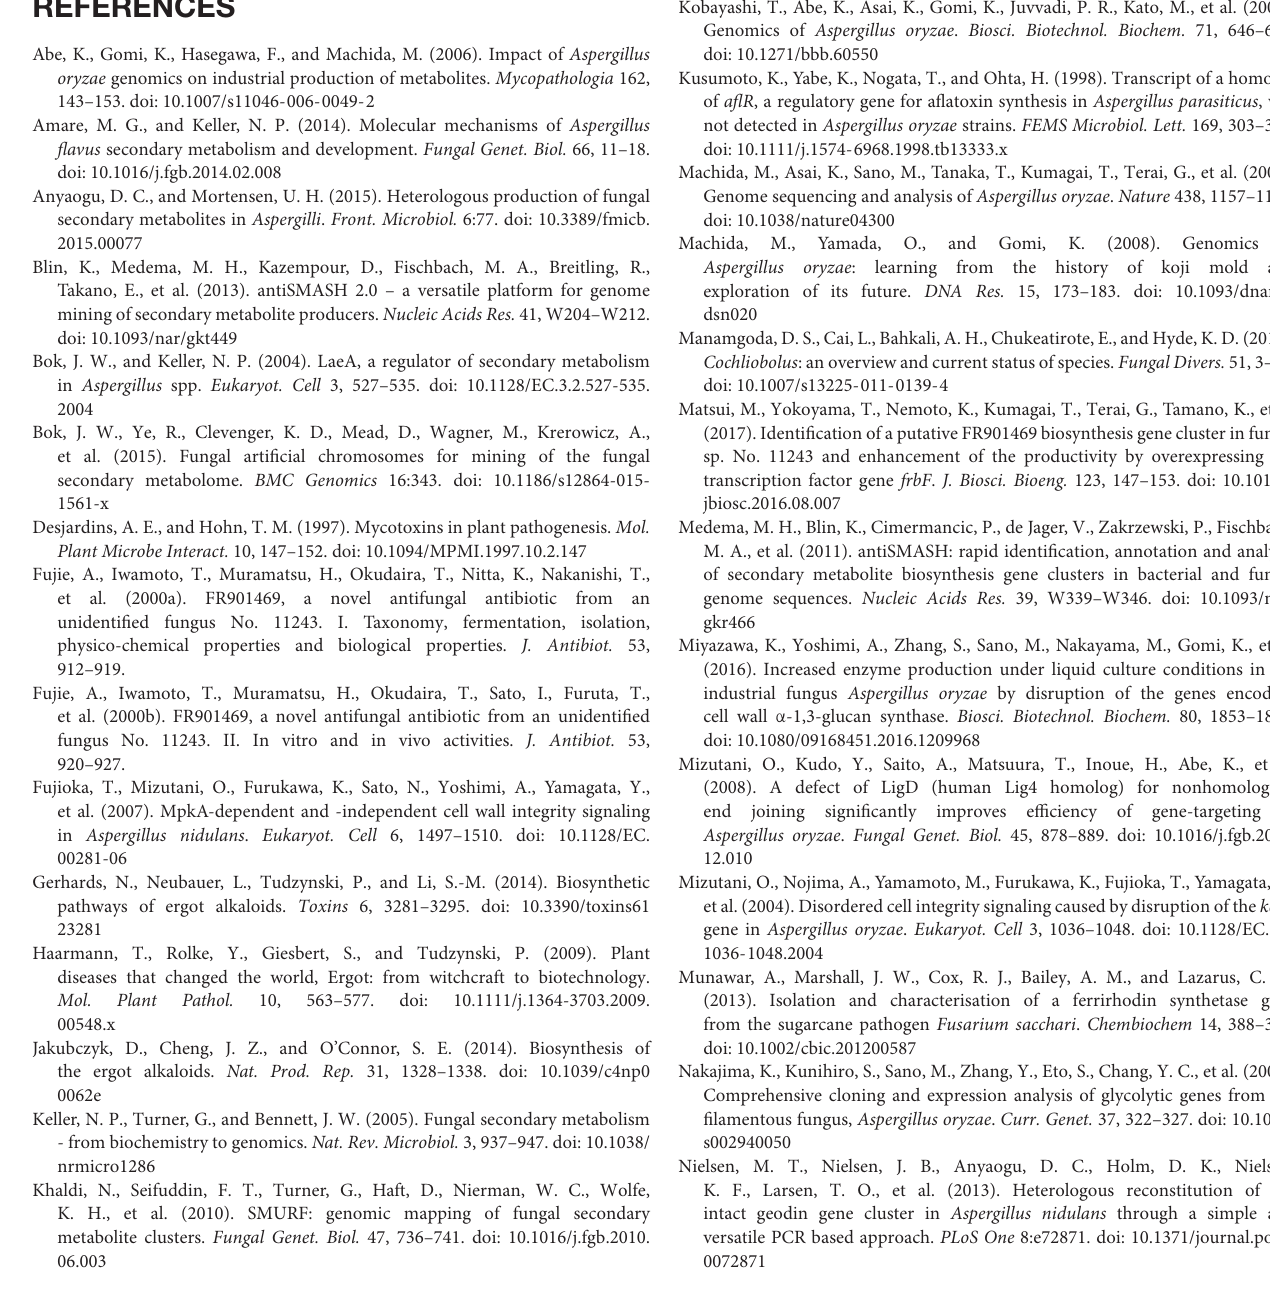
each strain. Data are means of three biological and two technical replicates, with standard deviations. Different letters indicate statistically significant differences among strains ( P < 0.05, Tukey’s multiple comparison test). FIGURE S5 | Activity of extract derived from strains of Aspergillus oryzae against Botrytis cinerea test strain. The test fungus B. cinerea was inoculated into the center of the petri dishes. Extracts from the culture supernatants were then dropped onto paper disks, which were then placed on the petri dishes. The fungus was grown at 26 ◦ C for 3 days. Antifungal activity was